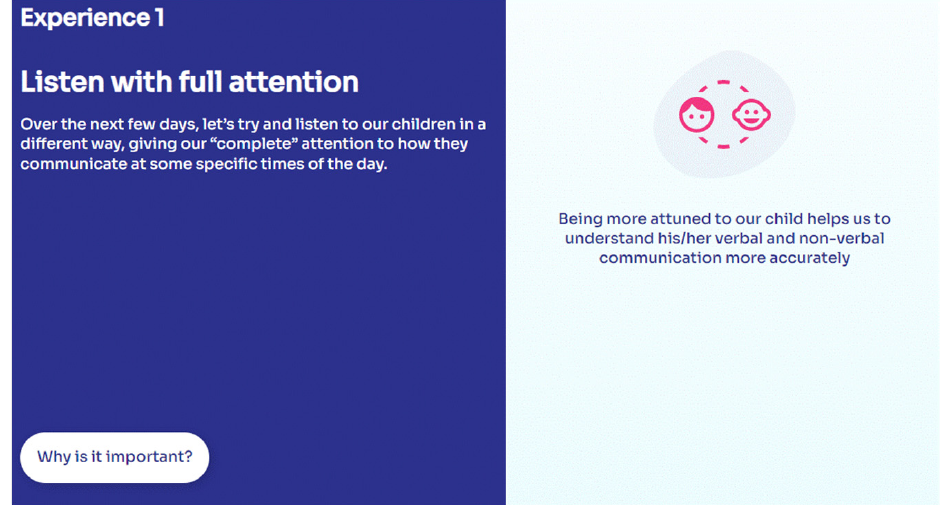
Figure 2. MinUTo app, an example of the section “Why is it important?” for the experience “Listening with full attention”.